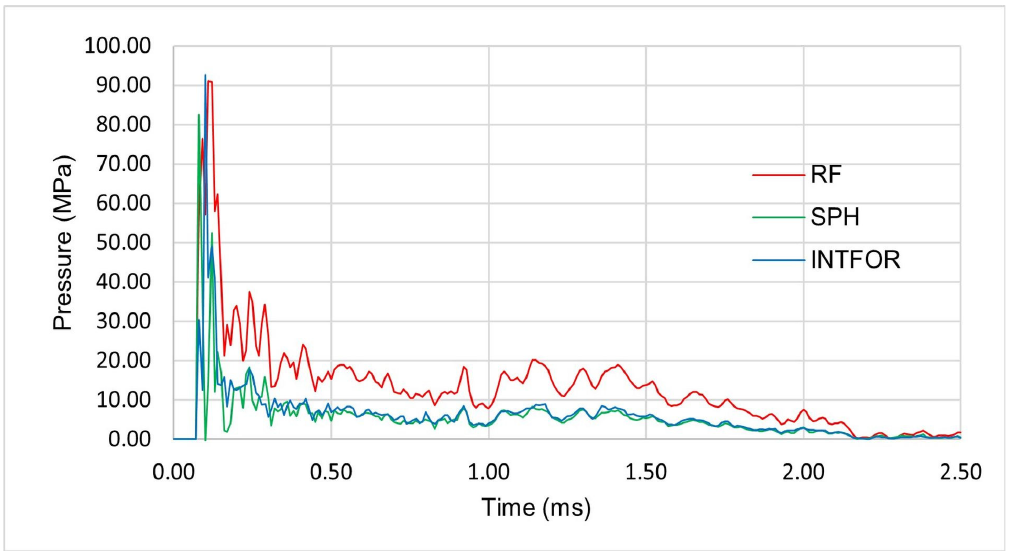
Figure 24. Pressure at center of impact for RF, SPH, INTFOR technique (MAT_3).